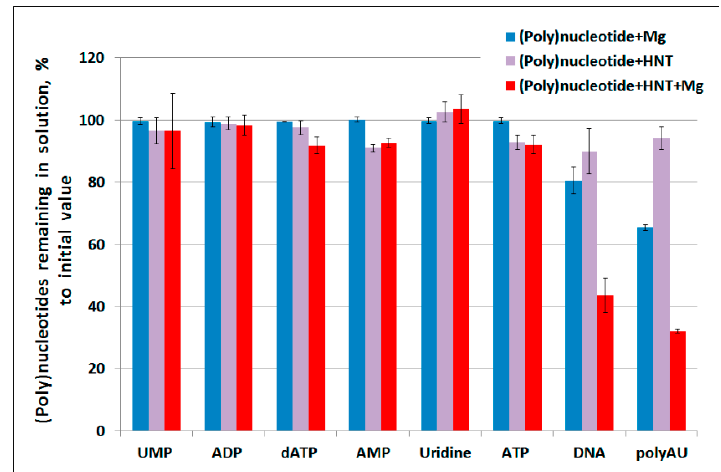
Figure 1. Binding of di ff erent (poly)nucleotides by halloysite nanotubes (HNT) with or without MgCl 2 (10 mM).